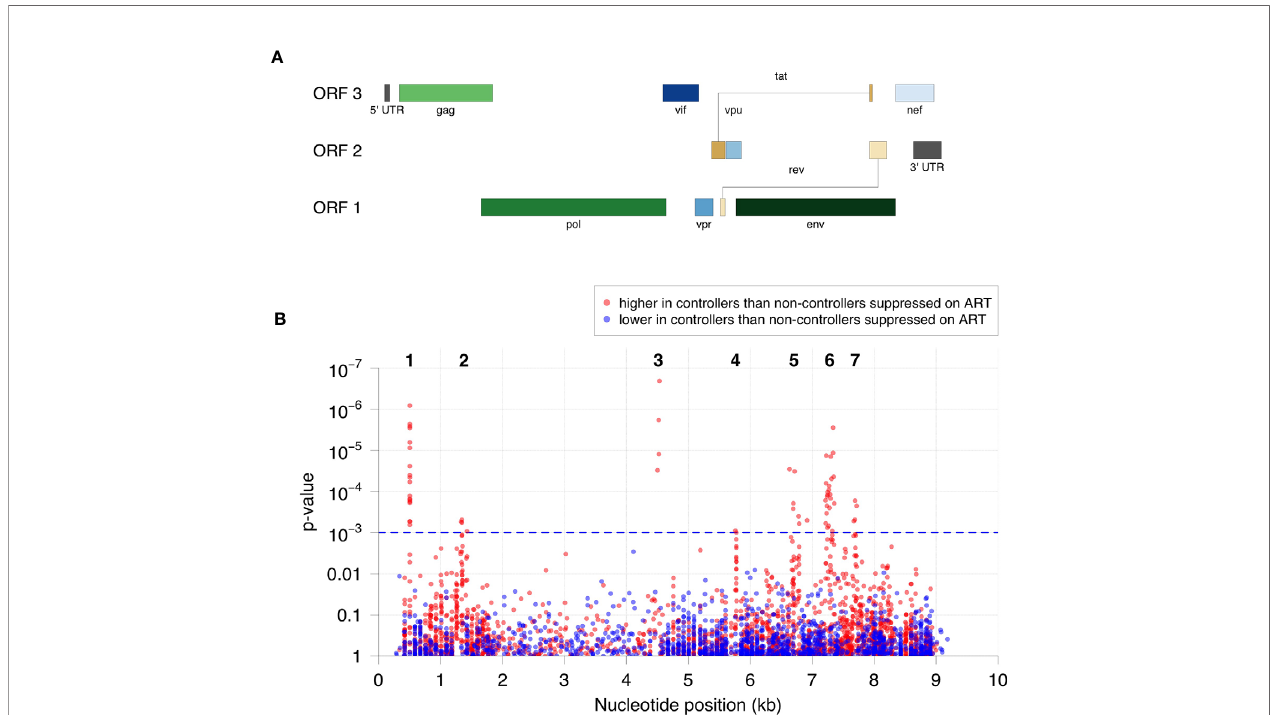
FIGURE 2 | Speci fi city of antibodies targeted in HIV controllers compared to non-controllers who were virally suppressed on ART. (A) The positions and lengths of open reading frames (ORFs) in the HIV genome are plotted relative to genomic coordinates for HIV (HXB2, NCBI #NC_001802). (B) The signi fi cance for the difference in antibody reactivity in controllers versus non-controllers who were virally suppressed on ART is shown for each peptide. The x-axis shows the position of each peptide in the HIV genome. The y-axis shows the -log 10 p-value based on moderated t-statistics for each peptide. Each dot shows the result for a single peptide. Red dots indicate peptides that had higher antibody reactivity in the HIV controller group. Blue dots indicate peptides that had lower antibody reactivity in the HIV controller group. The blue dashed line indicates the highest q-value less than 5% (q=0.0485), which corresponds to a p-value of 0.001. The 62 signi fi cant peptides with q-values <0.05 (above the blue dashed line) had signi fi cantly higher peptide reactivity in HIV controllers compared to non-controllers who were virally suppressed on ART. Cluster numbers (1-7) are noted above each group of clustered peptides (see Table 2